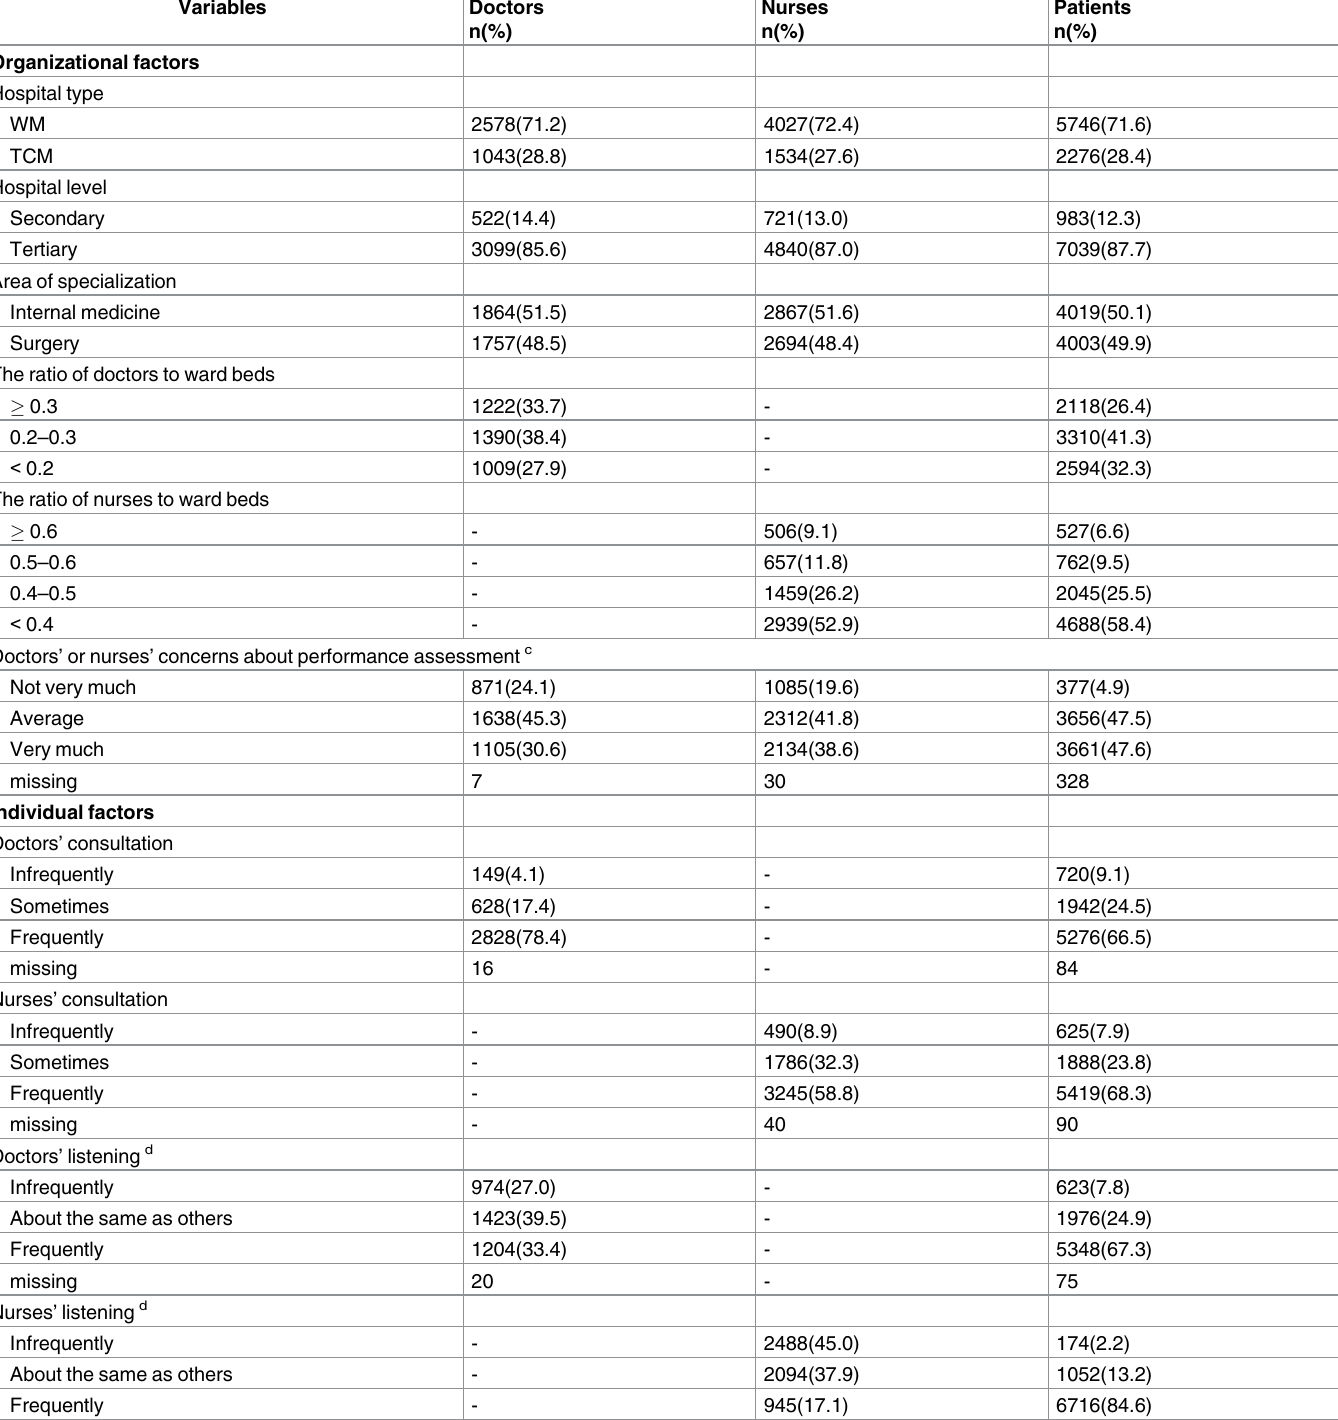
Table 2. Distribution characteristics of organizational and individual factors of the